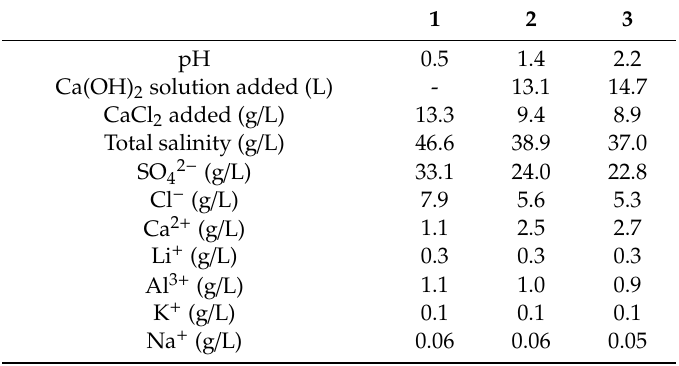
Table 9. pH and composition of raw material liquid separated by nanofiltration.